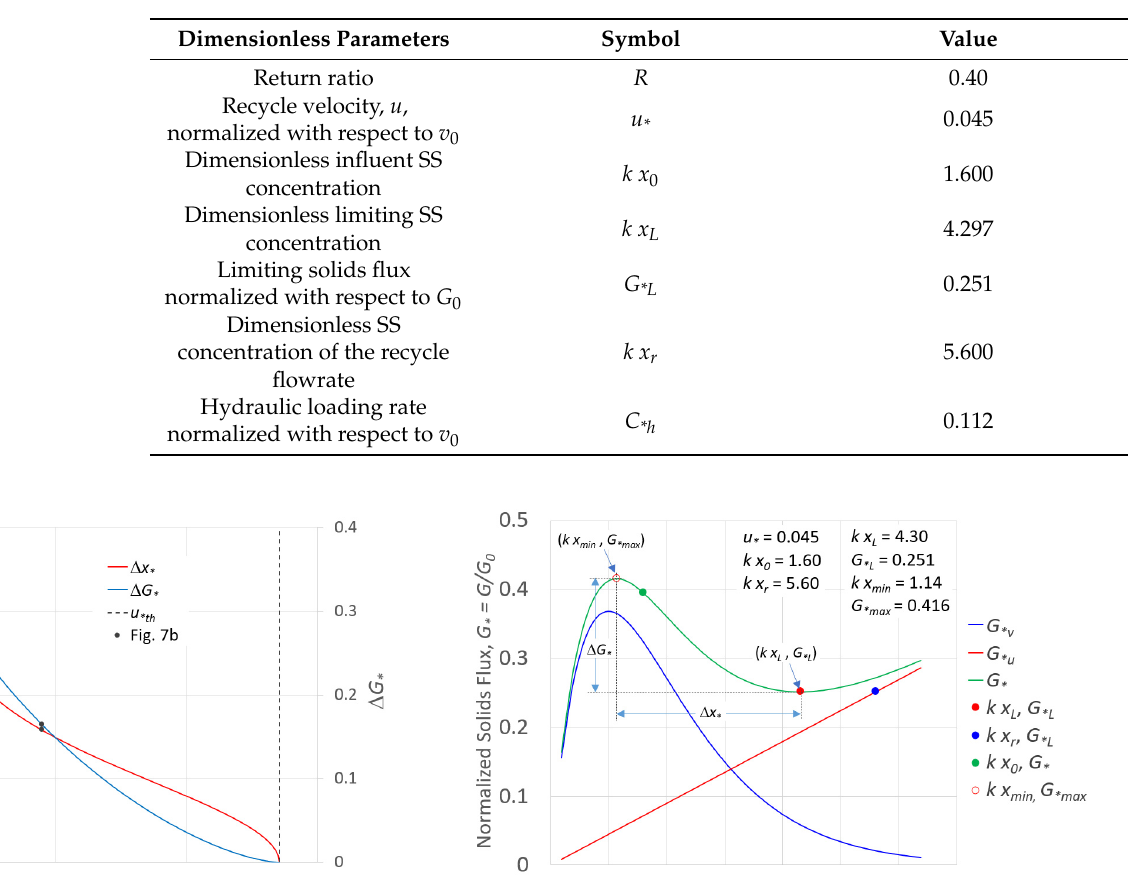
Table 3. Dimensionless groups and their symbols and values, corresponding to the application of Figure 7b.